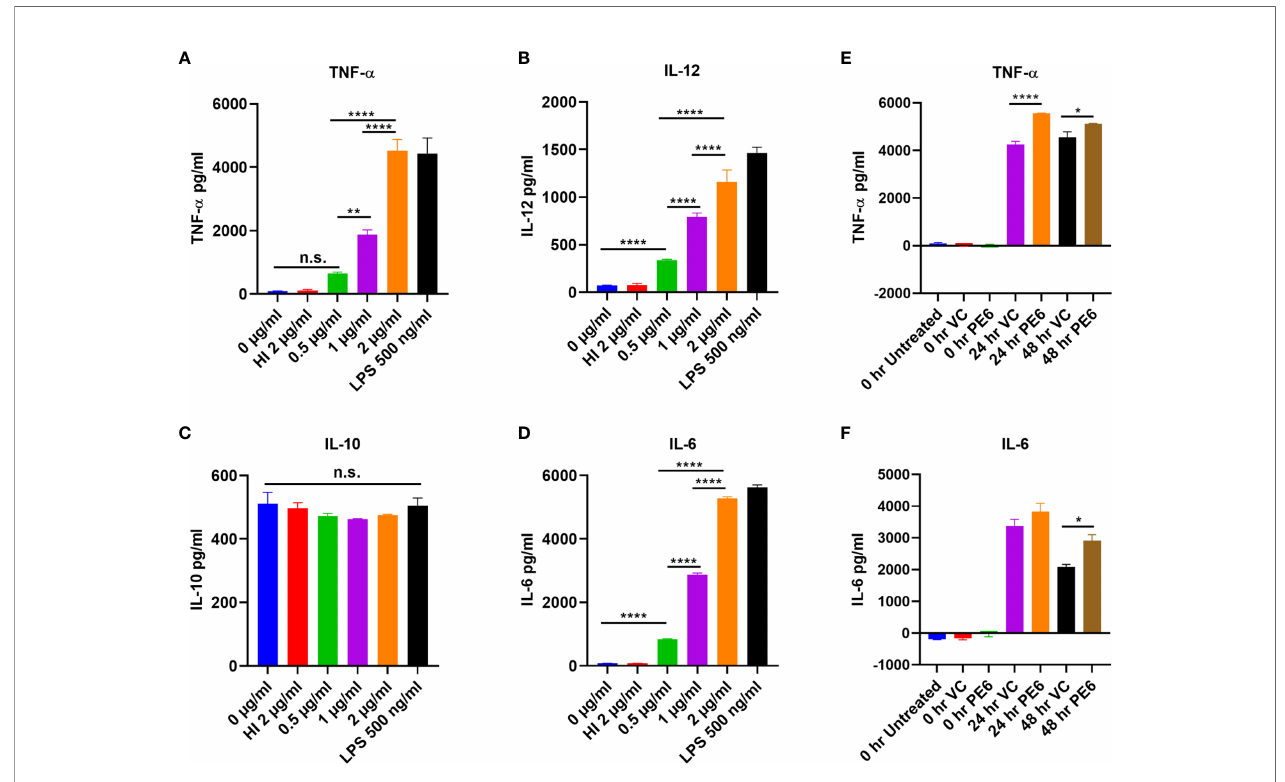
FIGURE 1 | PE6 is a proin fl ammatory molecule of M. tb , which induces robust secretion of proin fl ammatory cytokines. (A – D) RAW264.7 macrophage cells were treated with various concentration of PE6 (0.5, 1 and 2 m g/ml), LPS 500 ng/ml and HI PE6 (2 m g/ml). Sandwich ELISA was used to quantify cytokine TNF- a , IL-6, IL- 12, and IL-10 levels using the cell culture supernatants. LPS treatment was used as a positive control for the induction of proin fl ammatory cytokines. Untreated and HI PE6 treated cells were used as negative controls. Puri fi ed PE6 was treated with polymyxin B agarose beads for the removal of endotoxin, and one aliquot was digested with proteinase K, followed by heat inactivation at 100 °C for 4 h. (E, F) Three million RAW264.7 cells were seeded in a six-well tissue culture plate and left overnight for adherence. Cells were infected with recombinant M. smegmatis containing pe6 and vector alone cells at (MOI 1:10) for 24 and 48 h. TNF- a and IL-6 levels were measured using sandwich ELISA. Untreated and 0 h treated cells were used as negative controls. Data were analyzed by one-way ANOVA with Tukey ’ s multiple comparison post-test. Data are representative of three independent experiments. P values <0.05 were considered as signi fi cant. *P < 0.05, **P < 0.01 and, ****P < 0.0001 vs . controls. n.s., not signi fi